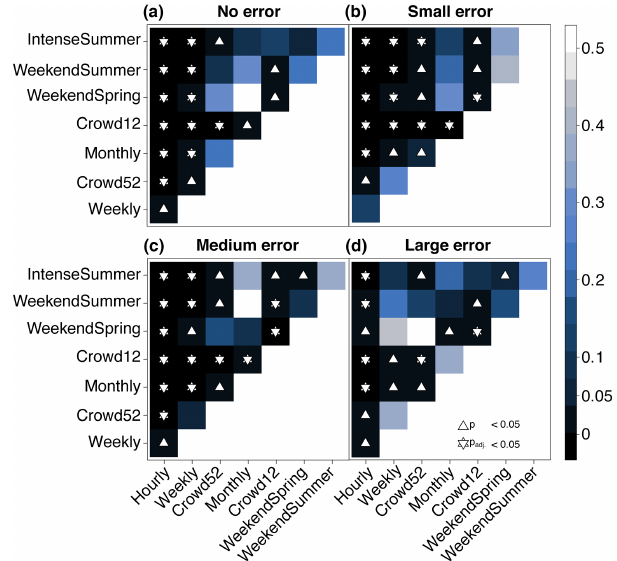
Figure 5. Results ( p values) of the Kruskal–Wallis with Bonfer- roni post hoc test to determine the significance of the difference in the median model performance for the data with different temporal resolutions within each data quality group (no error a , small error b , medium error c , and large error d ). Blue shades represent the p values. White triangles indicate p values < 0.05 and white stars in- dicate p values that, when adjusted for multiple comparisons, are still <